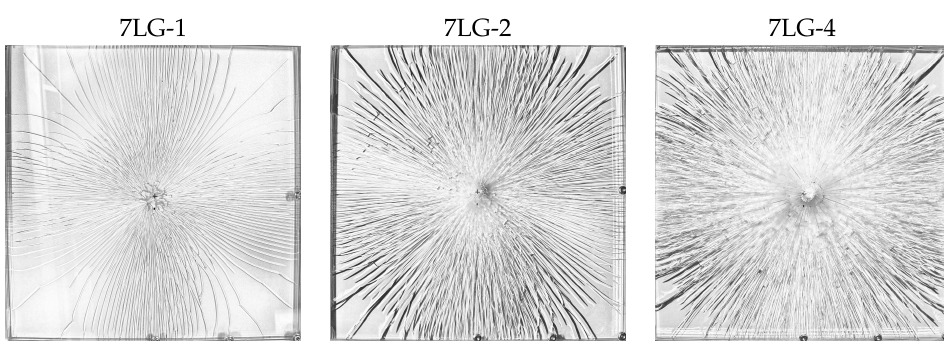
Figure 2. Final fracture patterns of 5LG samples.